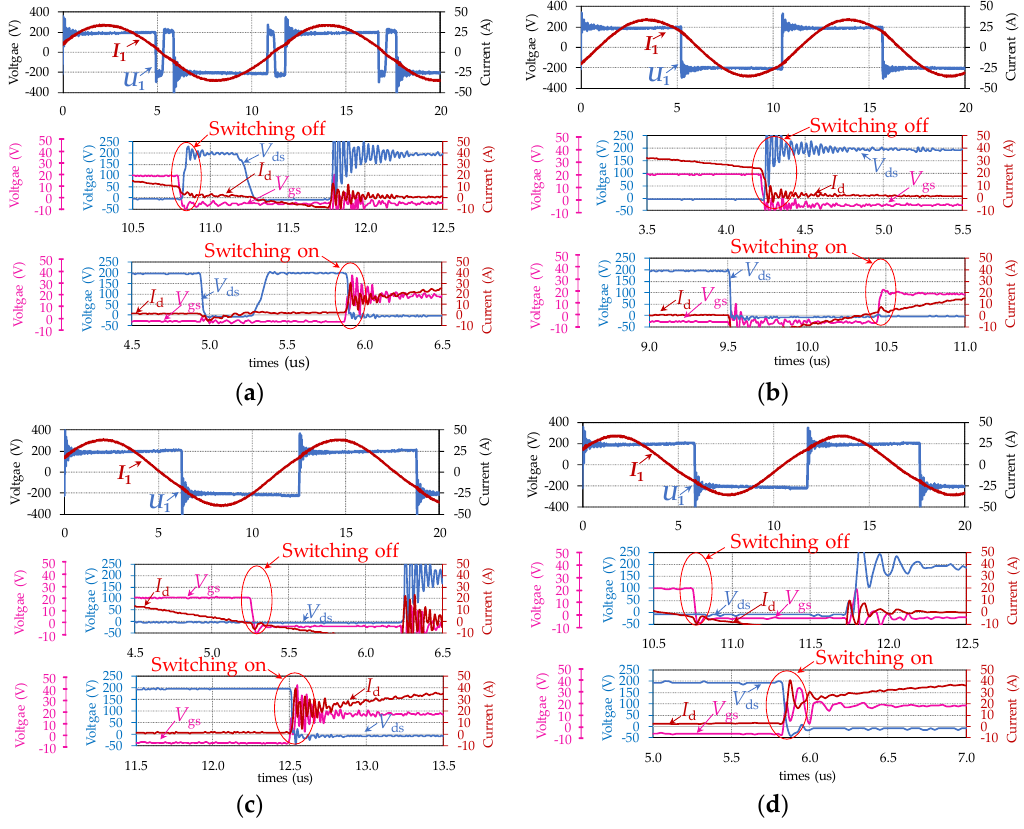
Figure 9. Experimental waveforms of the 85 kHz WPT system: ( a ) 85 kHz@85 kHz; ( b ) 95 kHz@85 kHz; ( c ) 80 kHz@85 kHz; ( d ) 85 kHz@95 kHz.